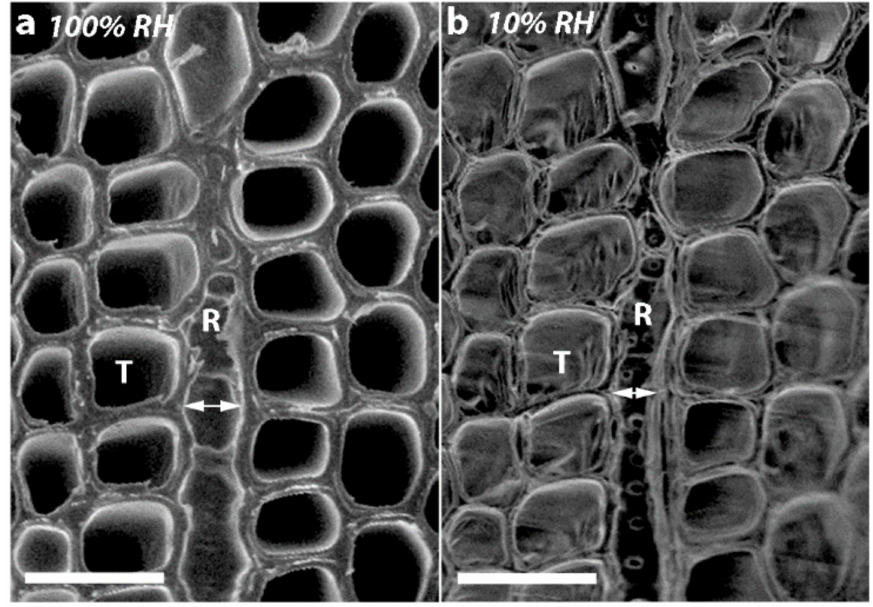
Figure 7. VP-SEM micrographs showing the cut transverse surface of a disc of MCW1 from Tree 1 ( a ) at 100% RH and ( b ) at 10% RH. The thin-walled, radial ray tracheid (R) shrank tangentially after drying to 10% RH. The distance between the two longitudinal walls of the ray tracheid (arrows) became much smaller after drying. T tracheid. Scale bar = 50 µ